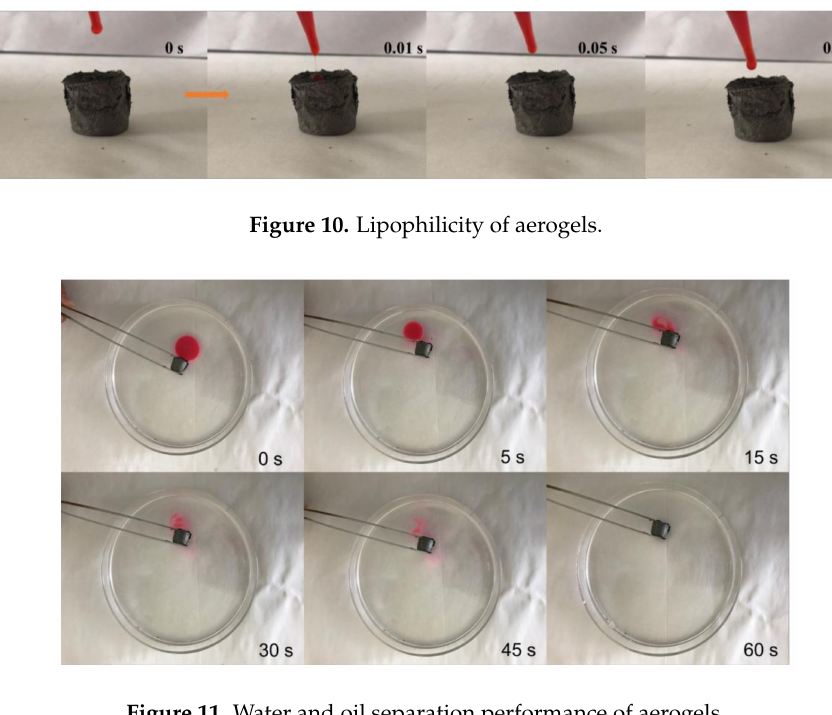
Figure 11. Water and oil separation performance of